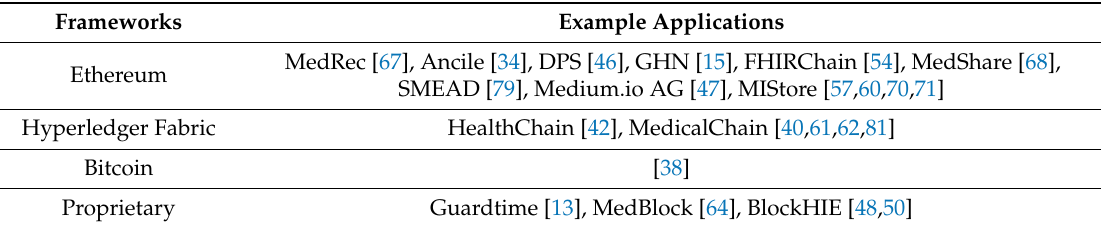
Table 6. Blockchain frameworks used in developing healthcare